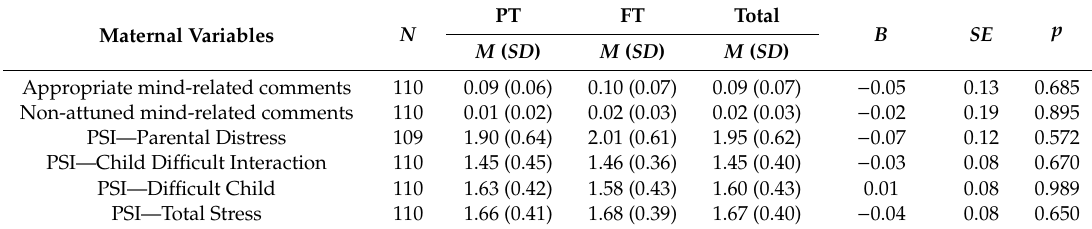
Table 2. Descriptive statistics and results of GAMLSS on the measures of mind-mindedness and parenting stress in mothers of preterm and full-term infants.